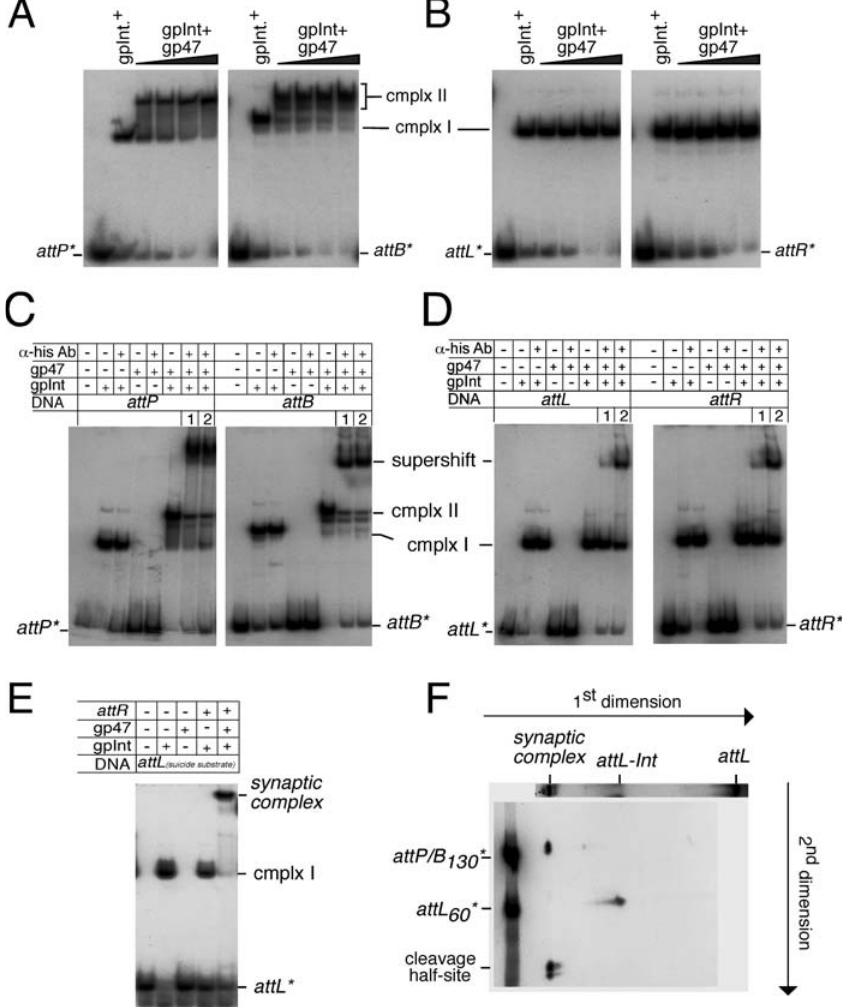
Figure 7. Substrate-Dependent Interaction of Bxb1 gpInt and gp47 (A and B) Binding of gpInt and gp47 to attP / attB / attL / attR was monitored by native gel electrophoresis. Radiolabeled DNA fragments ( ; 300 bp) were incubated with either gpInt (0.072 l M) alone or gpInt with increasing concentrations of gp47 (0.45, 0.89, 1.78, and 3.56 l M). The positions of DNA–gpInt complexes (cmplx I) as well as tertiary complexes containing DNA, gpInt, and gp47 (cmplx II) are shown. (C and D) The presence of gp47 in the tertiary complexes shown in (A) was determined by the ability of a -His antibodies to supershift complexes observed by native gel electrophoresis. a -His antibodies were either added to reactions containing DNA, gpInt, and gp47 (indicated as lane 1), or first preincubated with gp47 for 30 min and then added to reactions containing DNA and gpInt (lane 2). The protein–DNA complexes were separated from free DNA on a 5% native PAGE. The positions of the tertiary complexes of gp47, gpInt, and DNA as well as the antibody supershifted complexes are indicated. (E and F) Bxb1 gp47 is required for trapping a synaptic complex in excision. A suicide substrate version of attL DNA (5 9 radiolabeled at both ends) was used that has a nick on the top strand positioned four bases to the 5 9 side of the scissile bond. Bxb1 gpInt (72 nM) binds normally to this substrate to form Complex I (cmplx I), but when attR partner DNA (200 bp) and gp47 (3.56 l M) is added, no recombinant products are released. Instead, a prominent slow-moving complex is observed that absolutely requires Bxb1 gp47 for its formation. We have identified this as a synaptic complex using 2D-PAGE (F). In brief, a vertical gel slice was removed from the last lane in panel E, incubated with proteinase K and SDS, and then electrophoresed through a second dimension. Approximately 50% of the radiolabeled DNAs in this complex correspond to attP recombinant product and 50% correspond to a cleaved half-site. The bottom of the gel slice containing unbound attL DNA was removed prior to the second dimension of electrophoresis. Further details on the characterization of these suicide substrates will be described in future